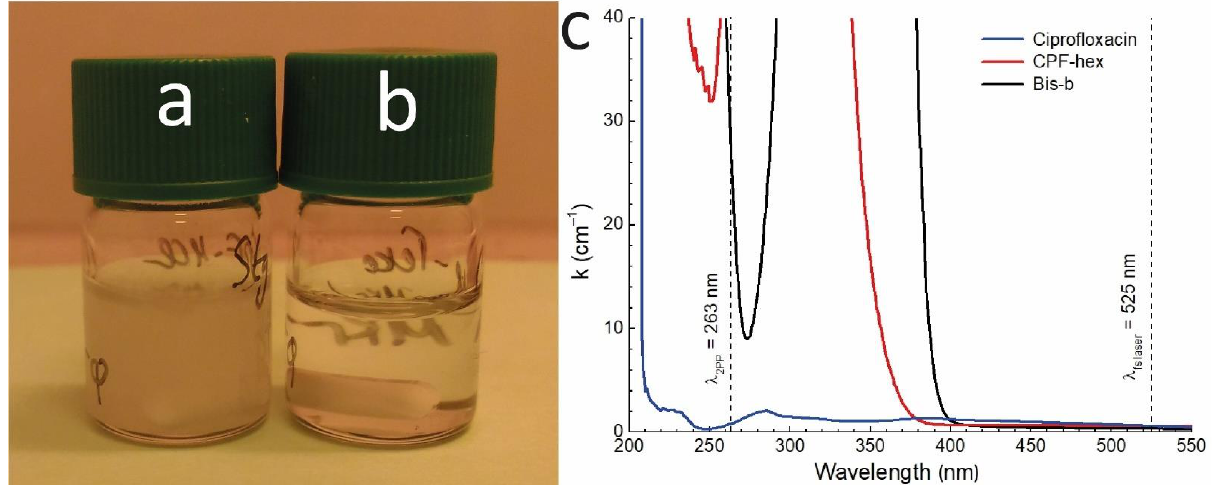
Figure 4. The ciprofloxacin ( a ) and CPF-hex ( b ) solubility in THF (800 µg/mL). ( c ): Absorption spectra of ciprofloxacin, hexanoylated ciprofloxacin (CPF-hex), 4,4 ’ -bis (diethylamino) benzophenone (Bis-b) in THF.